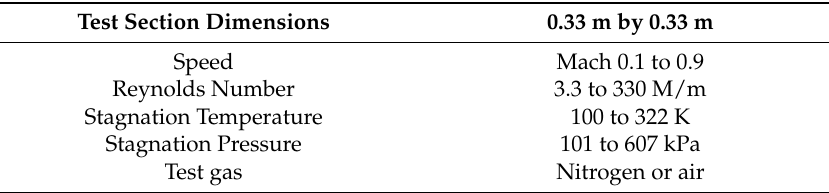
Table 1. Relevant characteristics of the 0.3-m TCT.